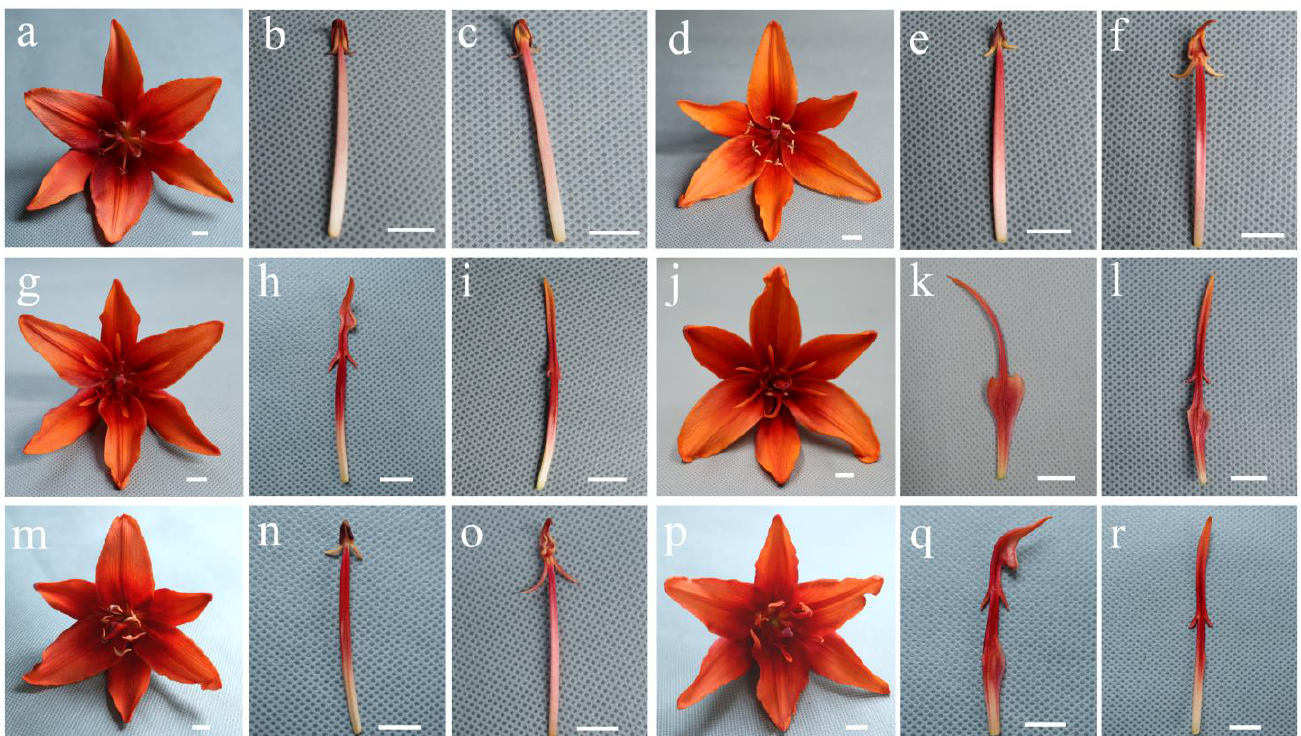
Figure 2. Morphological characteristics of flowers and floral organs in whorl 3 at the blooming stage under different temperature treatments. ( a – c ) Treatment T1. ( d – f ) Treatment T2. ( g – i ) Treatment T3. ( j – l ) Treatment T4. ( m – o ) Treatment T5. ( p – r ) Treatment T6. Treatments T1 – T6 are explained in Figure 1a. Bars = 1 cm. Table 2. Definition of the petaloid value of stamen at the blooming stage. Characterization Related Pictures